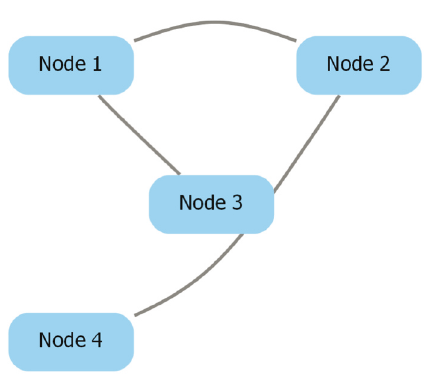
Figure 5. The network exported with the “Curved segments” option, as “splines = ‘curved’” in the output Graphviz file.